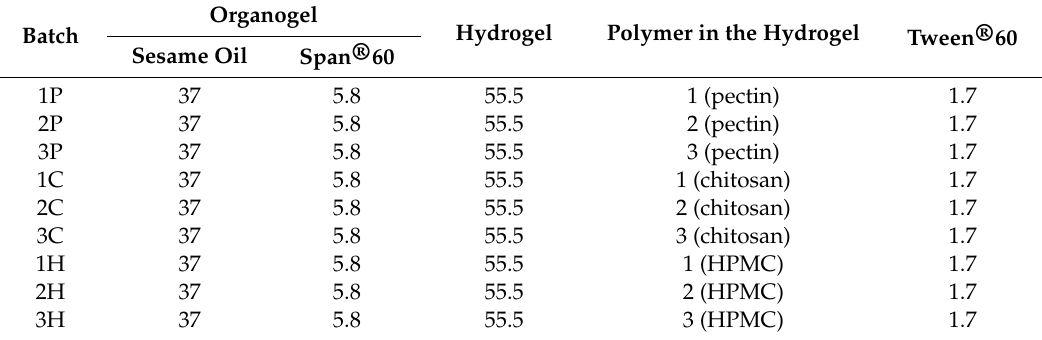
Table 1. Proportion of the components (% w / w ) in the formulated systems.